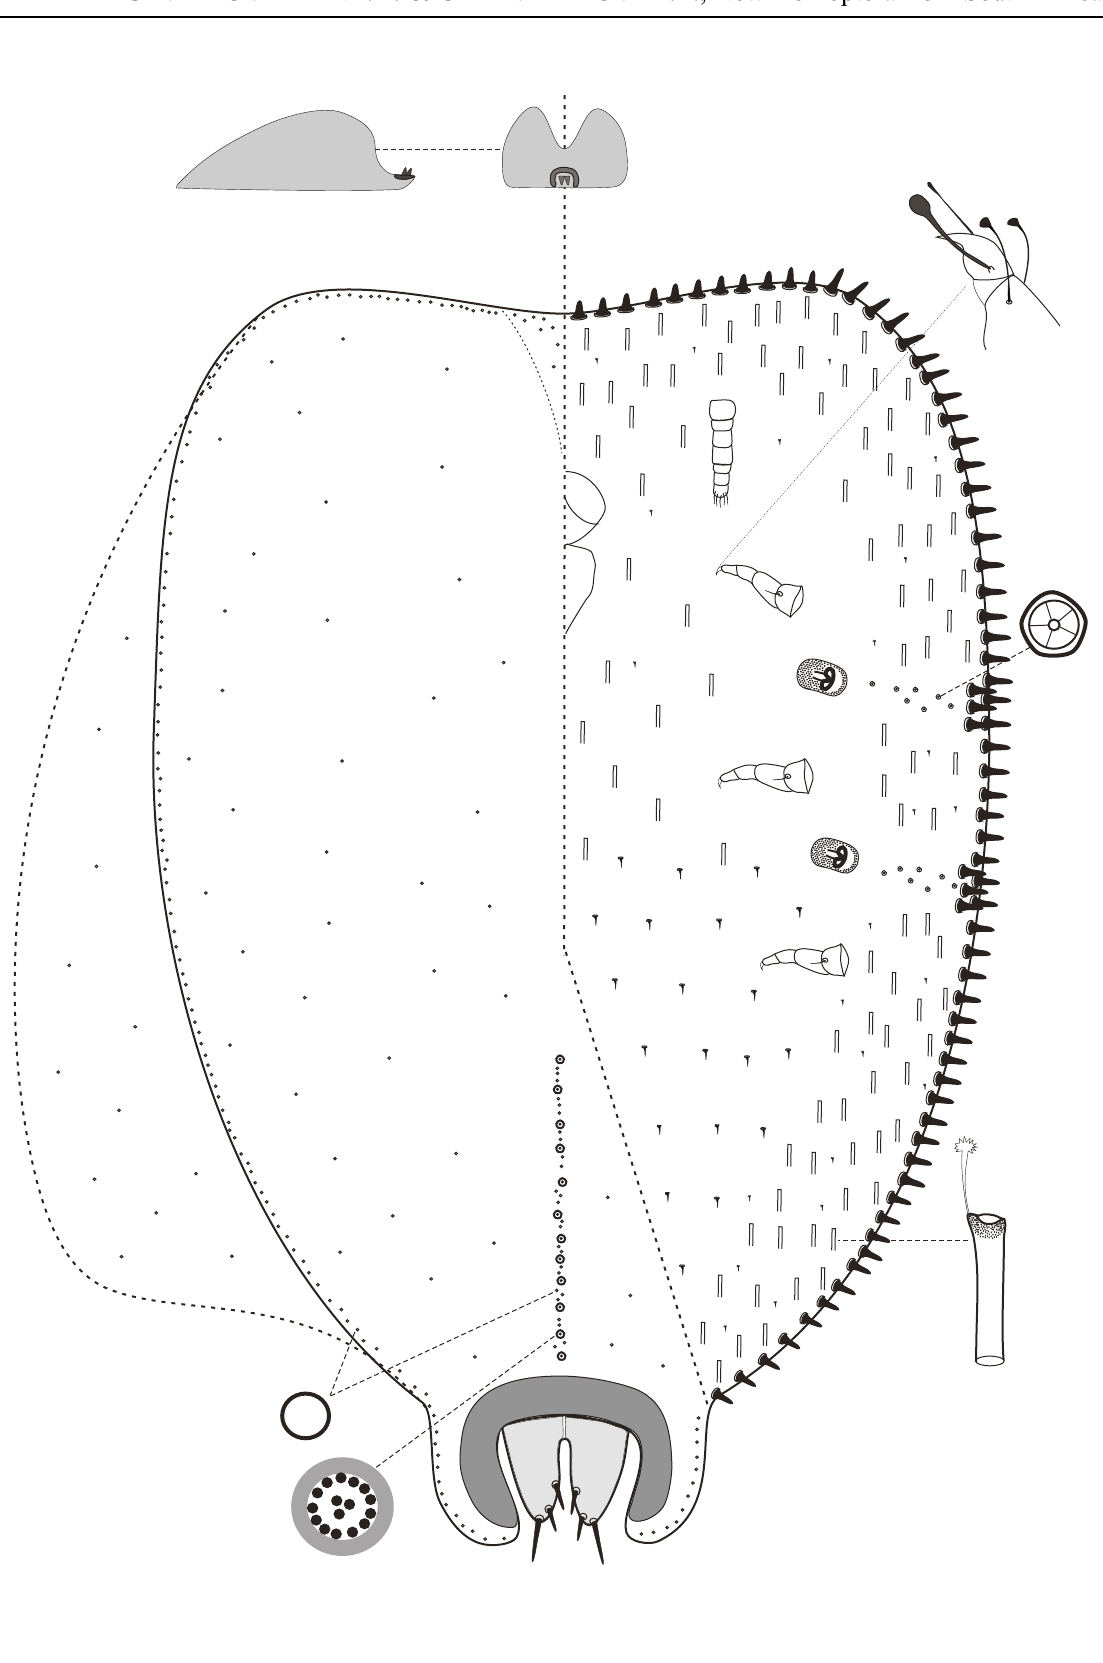
Fig. 4. Cryptinglisia millari Gavrilov-Zimin sp. nov., adult female,